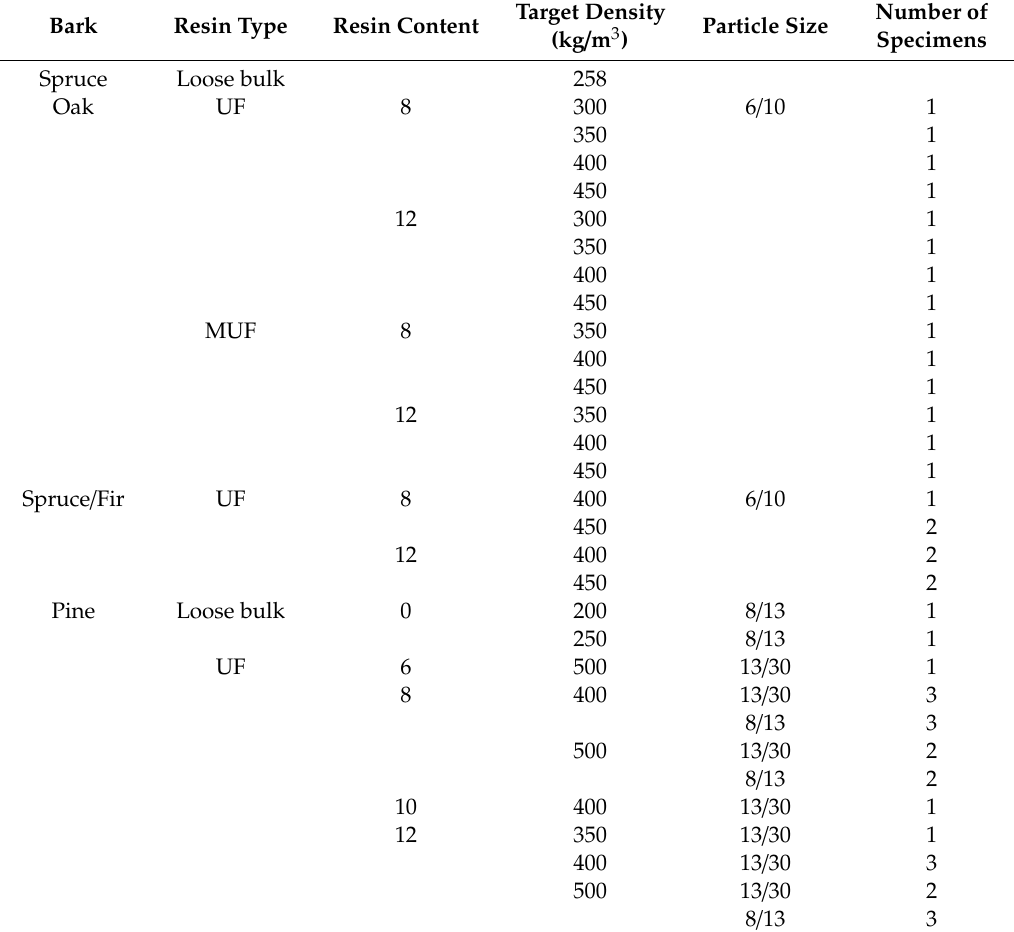
Table 1. Experimental design for bark insulation panels (spruce, oak, spruce / fir and pine). Bark